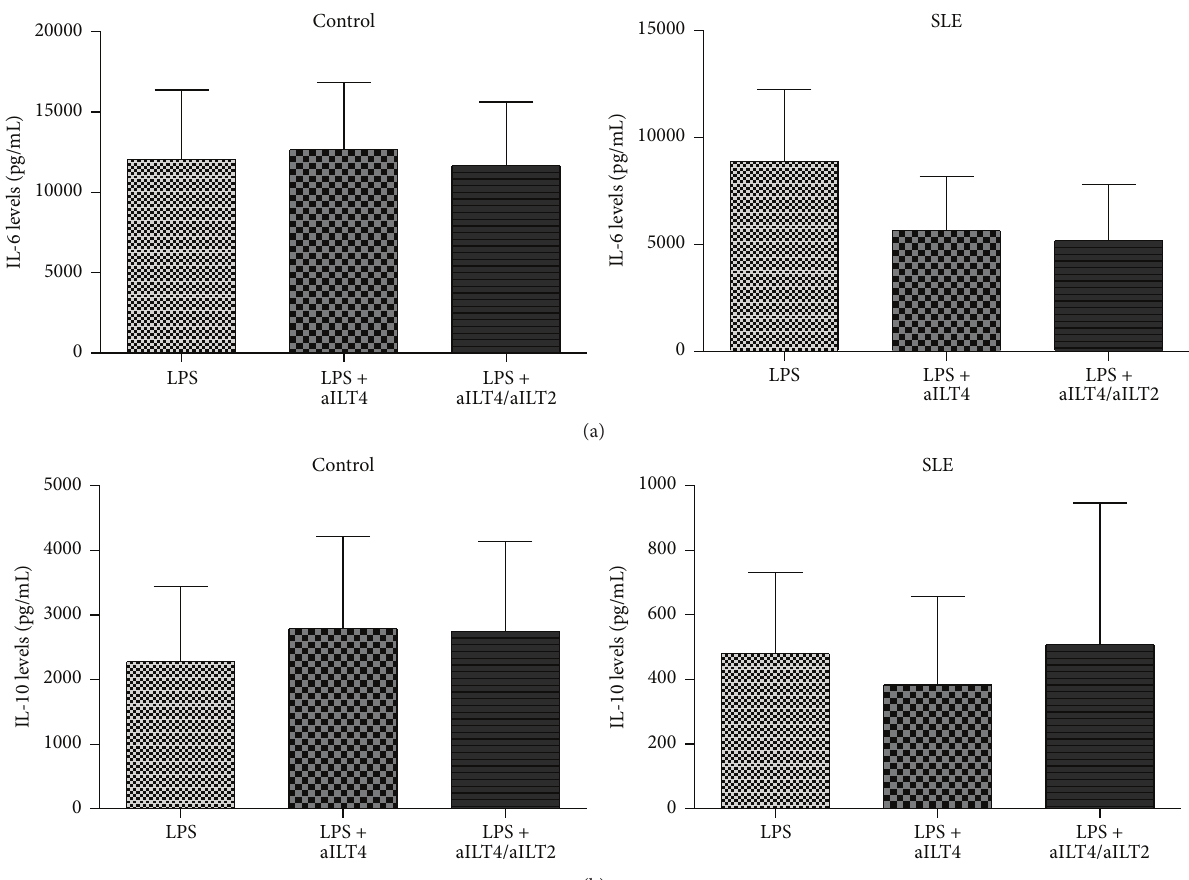
Figure 4: Effect of ILT4 ligation on cytokine release by DC from patients with SLE and healthy controls. DC generated in vitro with GM- CSF/IL-4 were maturated for 48 h with LPS or LPS with anti-ILT4 or LPS plus anti-ILT4/anti-ILT2 agonistic mAbs (aILT4/ILT2). Then, culture supernatants were obtained, and the concentrations of the indicated cytokines were determined by flow cytometry. (a) Levels of IL- 10 in culture supernatants from healthy controls (left panel) and SLE patients (right panel). (b) Levels of IL-6 in culture supernatants from healthy controls (left panel) and SLE patients (right panel). Results are shown as the median and the interquartile